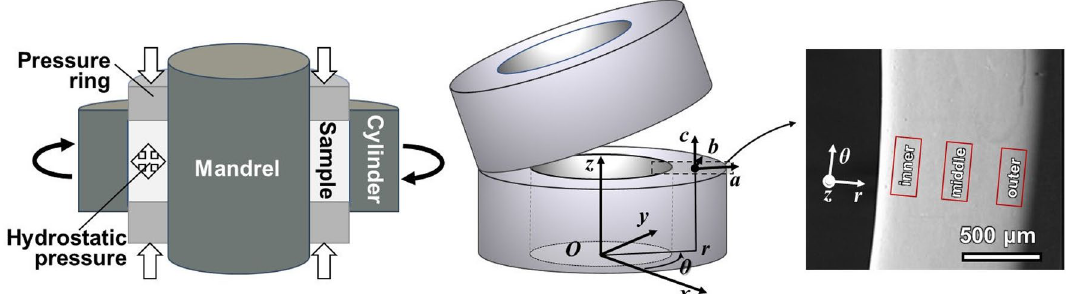
Figure 1. Illustration of the principle of t -HPS (left), the sample tube for t -HPS in cylindrical coordinates (center), half-height annular section of the tube wall with the observation regions: inner, middle and outer (right). Two sets of coordinate systems are defined: the macroscopic sample coordinate system is expressed in cylindrical coordinates r–θ–z and the local Cartesian coordinate system in terms of a–b–c . At any local position, these two coordinate systems always keep r parallel to a , θ parallel to b , and z parallel to c